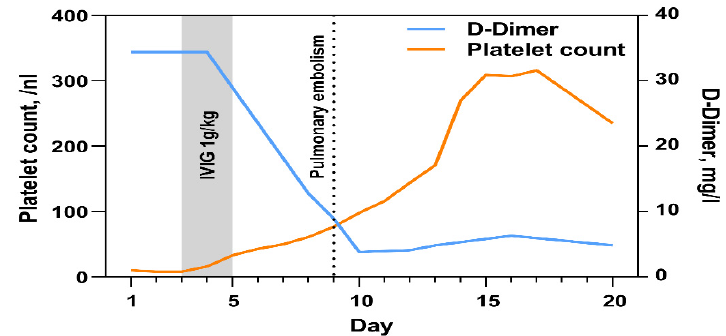
Figure 1. Platelet count and D-dimers during the first 20 days of hospitalisation.